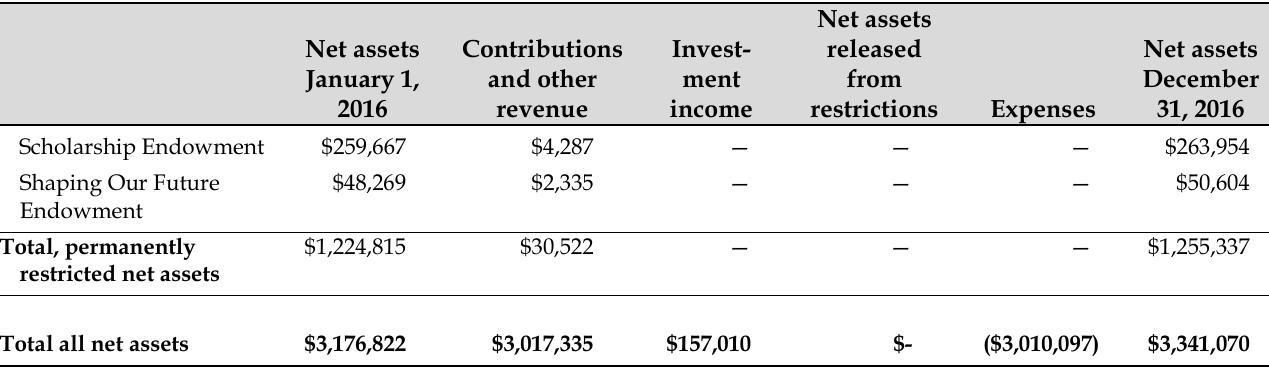
Table 1 Medical Library Association schedule of changes in net assets by fund year ended December 31, 2016